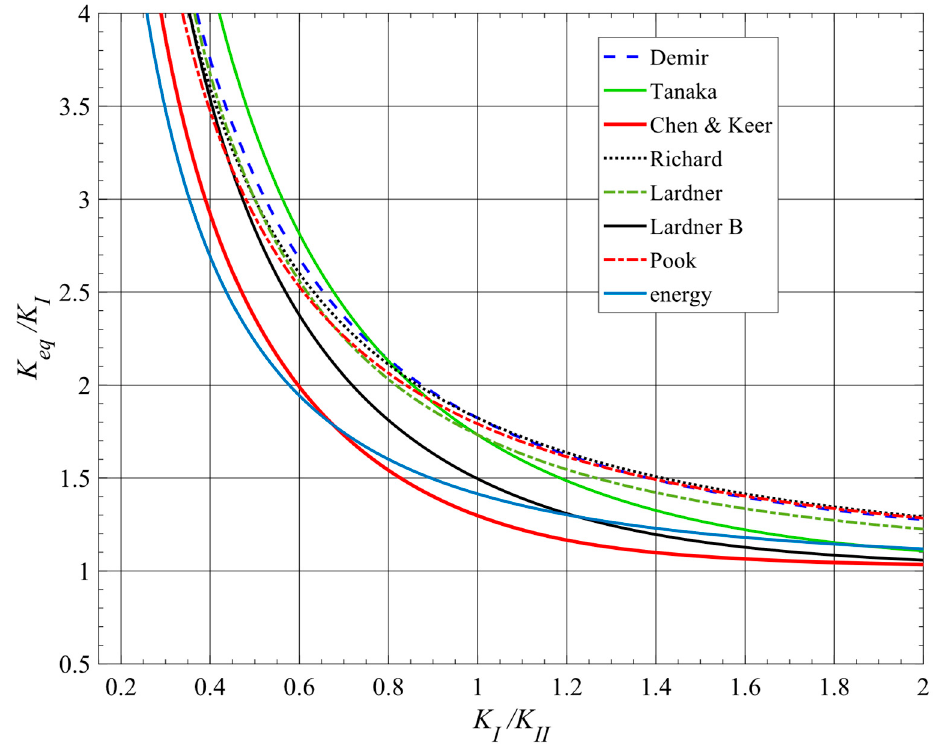
Figure 1. Non-dimensional K eq / K I as a function of K I / K II ; region K I /K II < 2. Within the range of K I and K II values of Figures 1 and 2, Demir’s approach [27,28] leads to K eq values that approximately follow the trend of other K eq approaches. Nevertheless, the format of Equation (19) and its resulting curve in Figure 2 raised an interest in analyzing its behavior over a wider range of K I and K II values. Notice that, unlike the others, Demir’s curve shows a noticeable decrease of the derivative as K II /K I increases. Indeed, Equation (19) shows K eq / K I = 0 for K I / K II = 0.178, which results from: